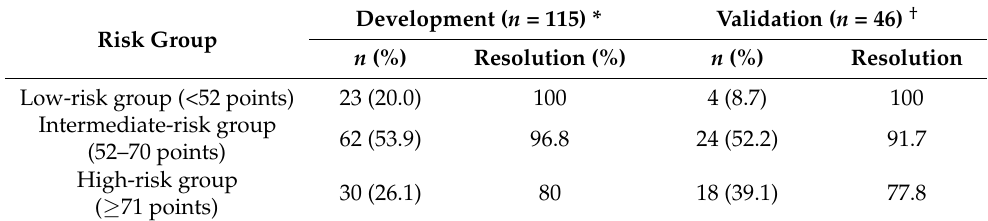
Table 4. VUR resolution prediction by risk group.